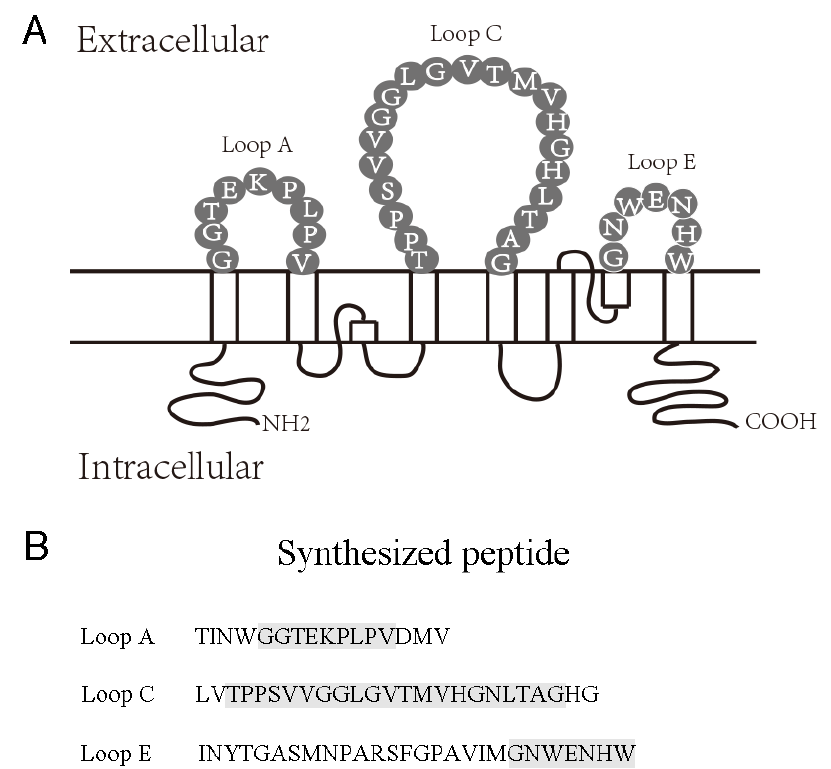
Figure 5. AQP4 extracellular epitopes and synthesized peptides. ( A ) Schematic representation of hu- man AQP4 residues constituting extracellular Loops A, C, and E. ( B ) Synthesized AQP4 extracellular mimotope peptides.